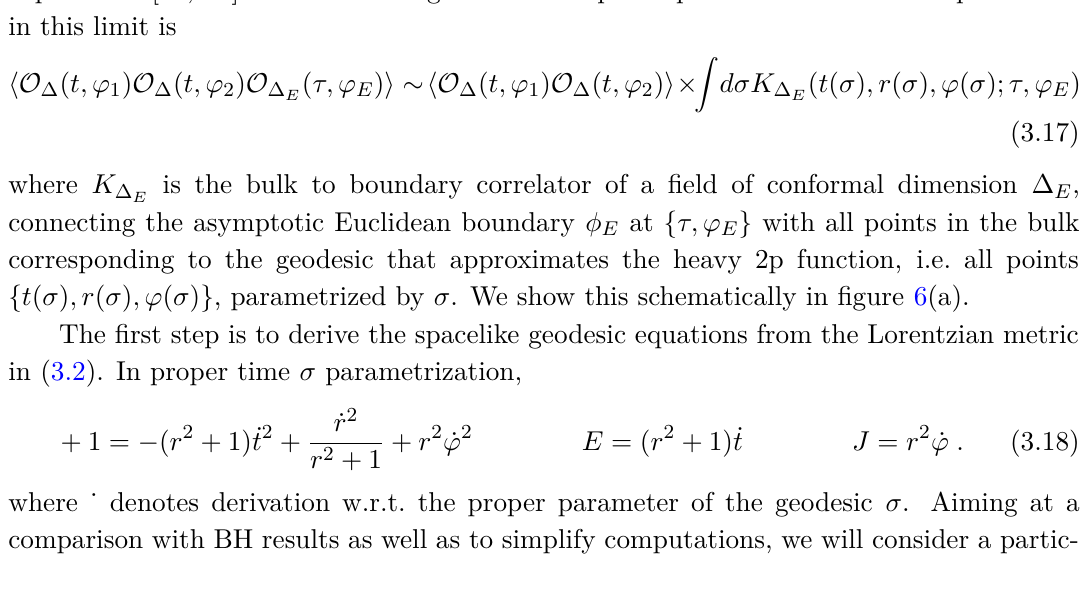
Figure 6. (a) We show a representation of F 2 in the HHL limit, when 2∆ (cid:29) ∆ E ∼ 1 . In this limit, one computes the geodesic between the Lorentzian points and computes the convolution of its curve with the profile φ having the bulk to boundary as kernel. (b) When 2∆ > ∆ approximate the Euclidean leg by a geodesic. One then must compute a saddle between spacelike and time-like/Euclidean geodesics. The correct way to perform this computation usually involves loosing a “curve on complex spacetime” representation of the correlator, so the figure should be taken as a pedagogical representation of the computation rather than an actual geodesics